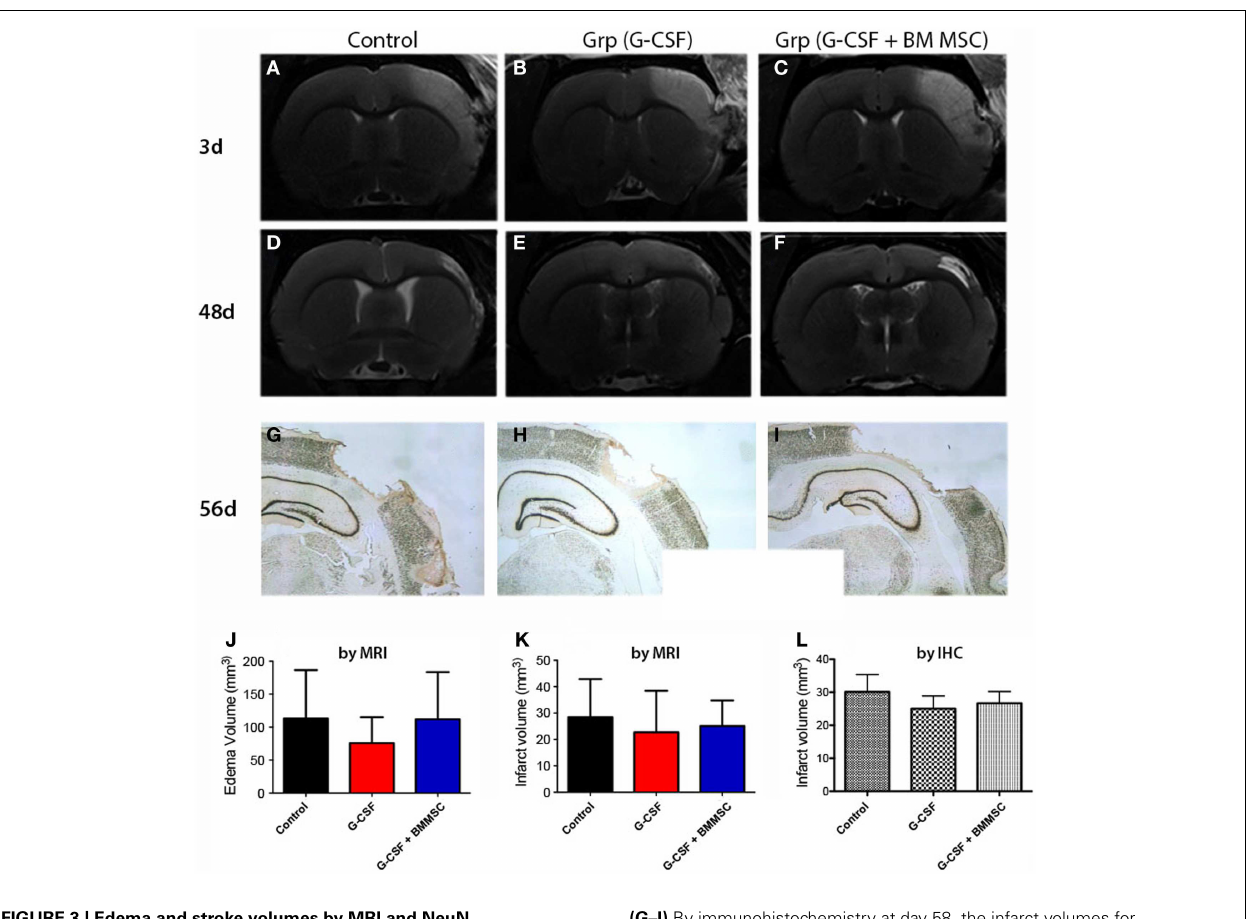
FIGURE 3 | Edema and stroke volumes by MRI and NeuN immunohistochemistry . (A–C) Perilesional brain edema at day 3 post-stroke, as defined by the region ofT2 hyperintensity (A) was not significantly reduced by any treatment (J) . (D–F) The second MRI done at day 48 (B) post-stroke revealed much smaller